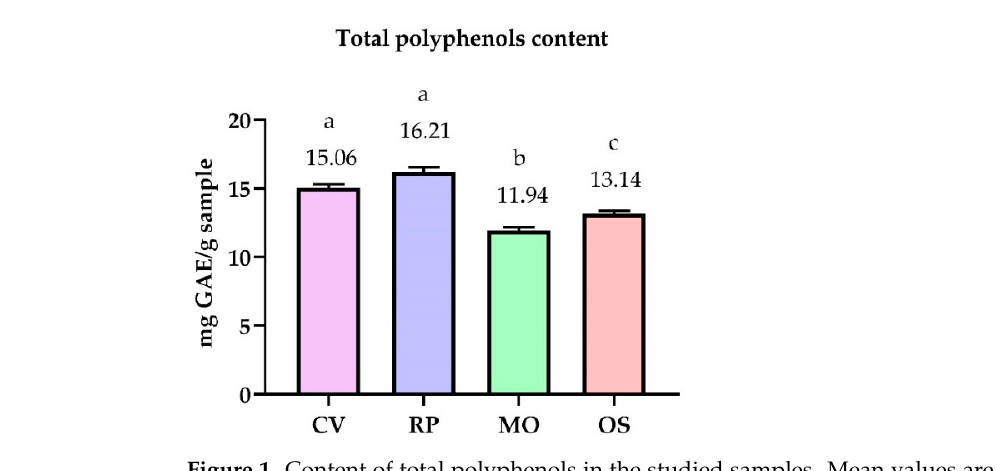
Table 2. The individual profile of polyphenols detected using the LC method (mg·g − 1 ). Compound